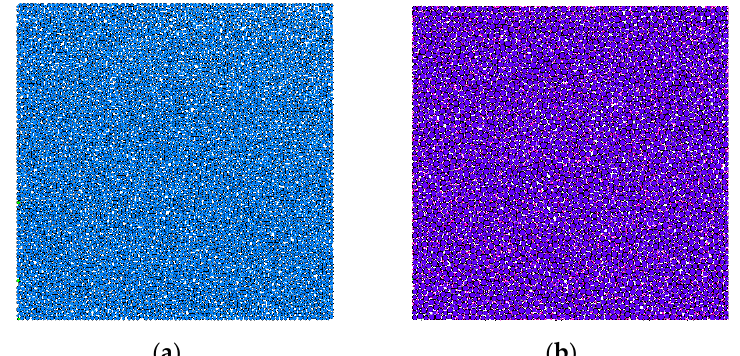
Figure 6. Simulation diagram of compression specimens. ( a ) Ordinary concrete. ( b ) Nano-TiO 2 modified concrete.